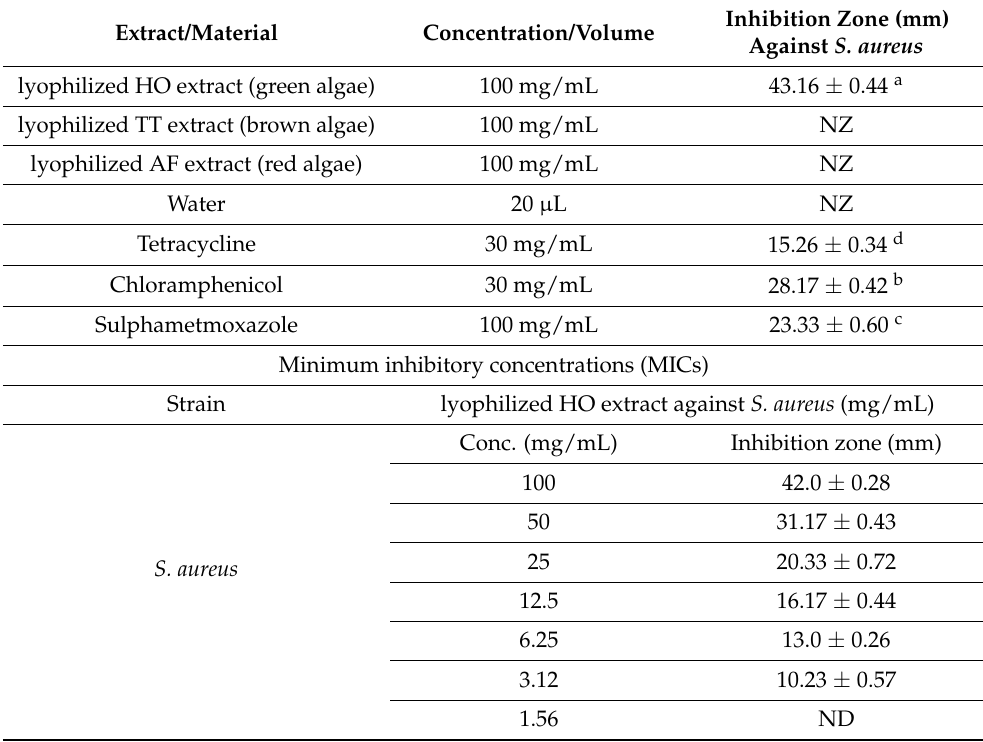
Table 1. Antibacterial activity and minimum inhibitory concentrations (MICs) of lyophilized sea- weeds’ extracts against S. aureus using agar disk diffusion assay.